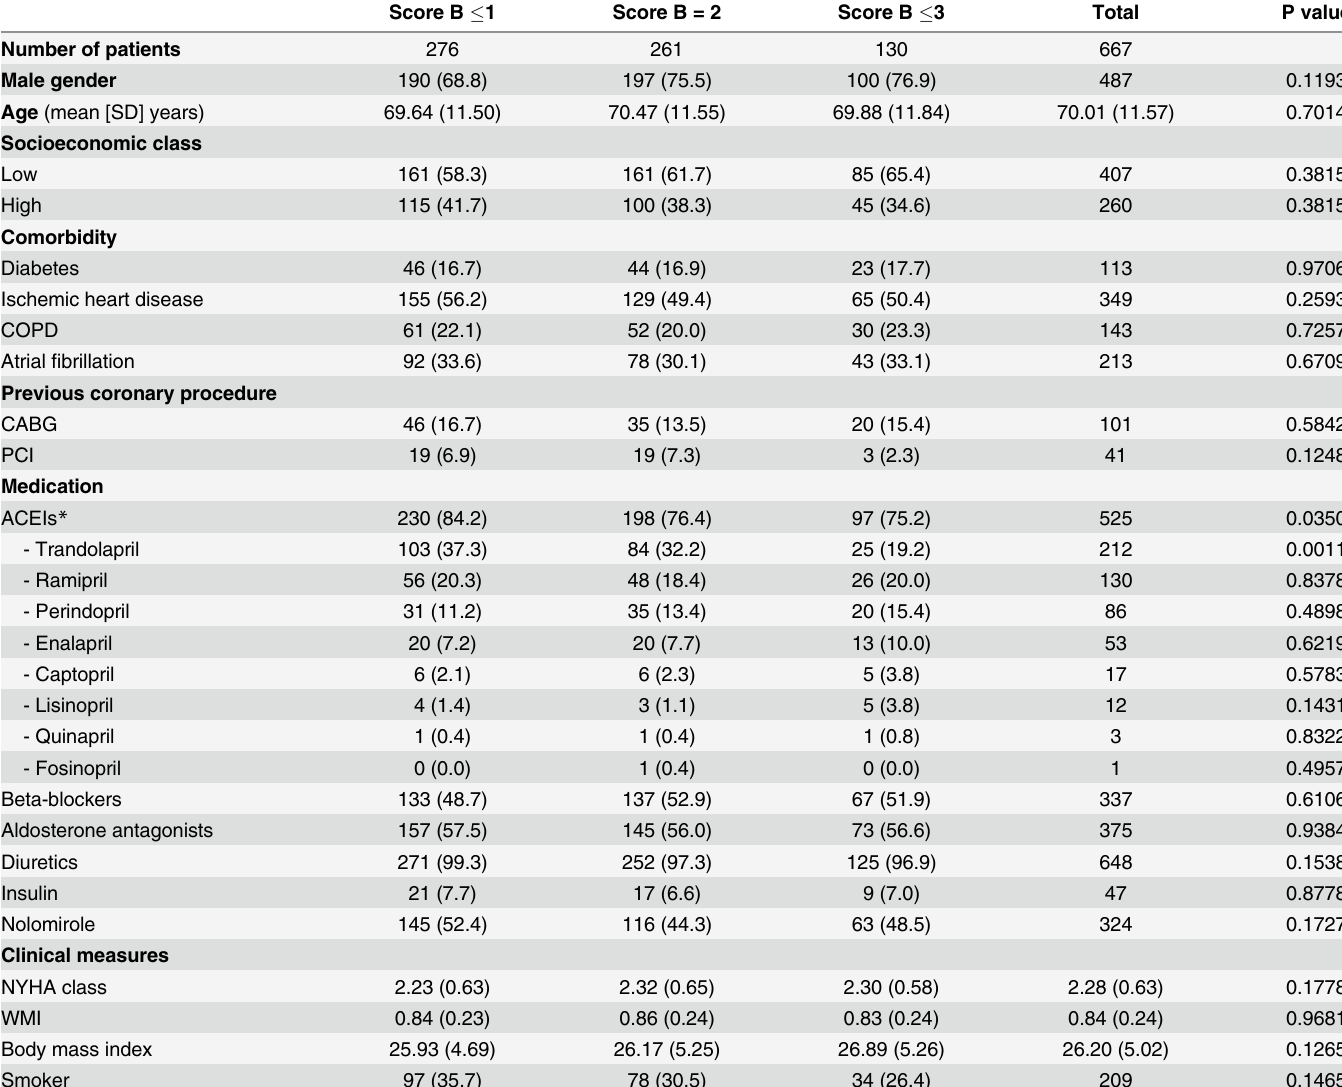
Table 2. Baseline clinical characteristics for patients with genetic score